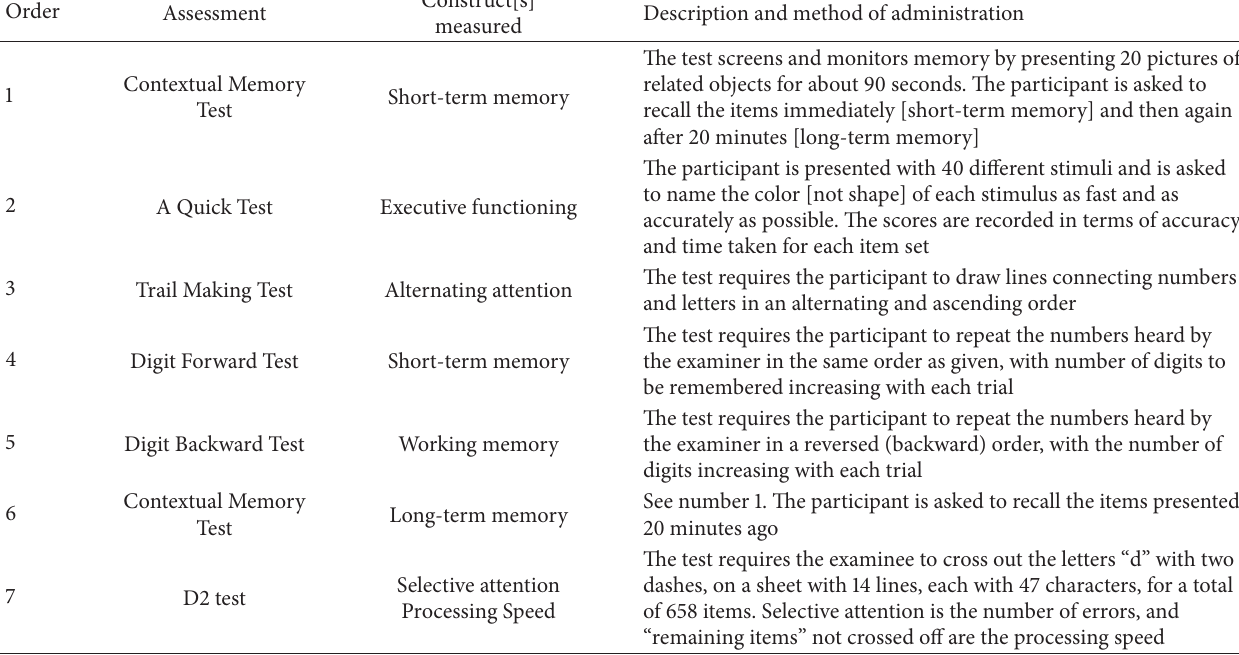
Table 1: Description of the cognitive outcome measures (in order of use in the